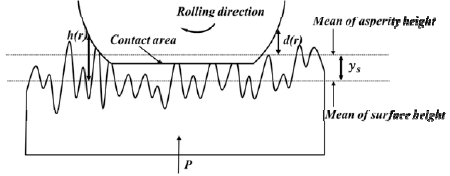
Figure 1. Contact model of a rigid smooth sphere on rough flat